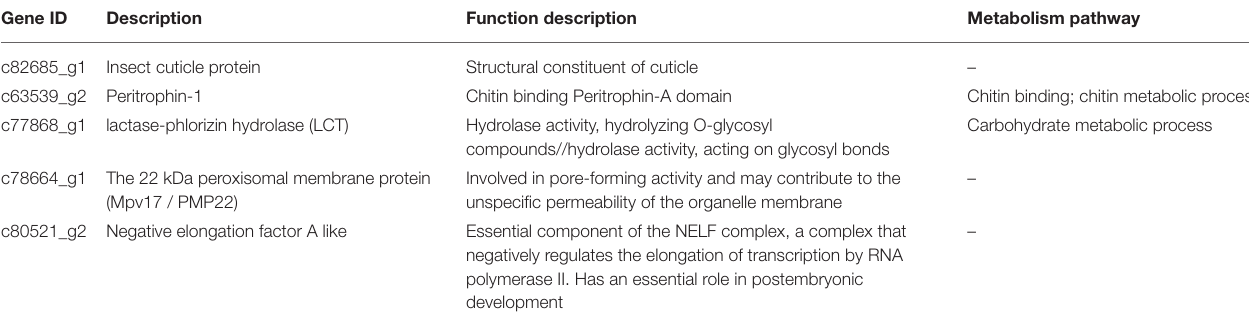
TABLE 3 | Differentially expressed genes (DEGs) shared with four